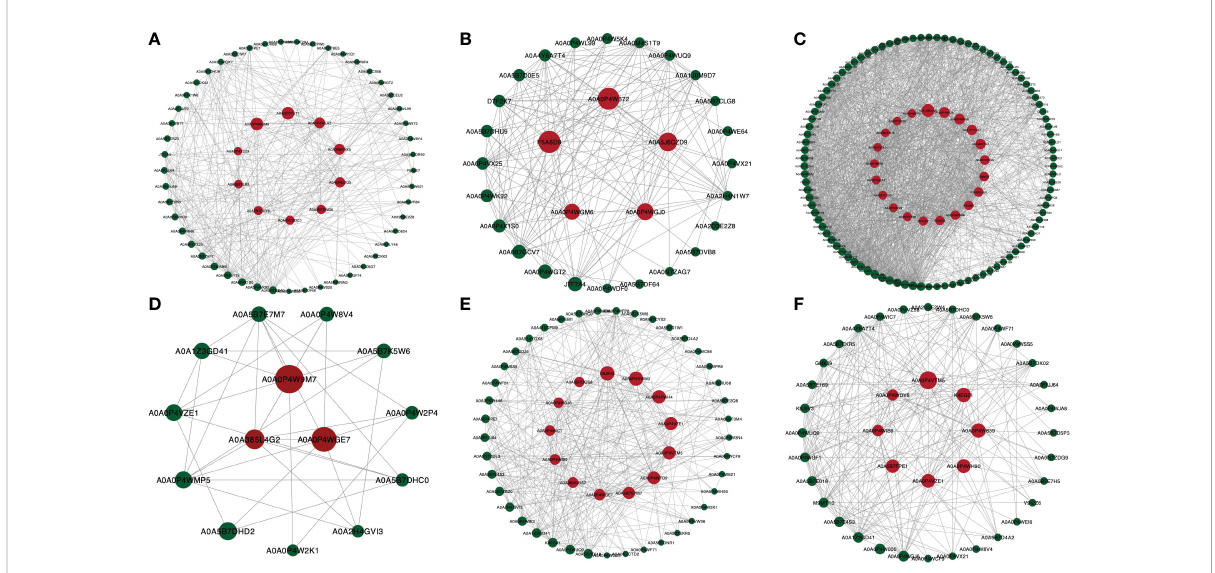
FIGURE 13 Results of Protein-protein interaction (PPI) network analysis for the betweenness of DEPs for M. nipponense exposed to different salinity gradients in the gills (A – C) , and hepatopancreas (D – F) at 7, 14 and 21 ppt comparison treatment, respectively. The red dot indicates the DEPs with high betweenness; the dot size corresponds to the degree of